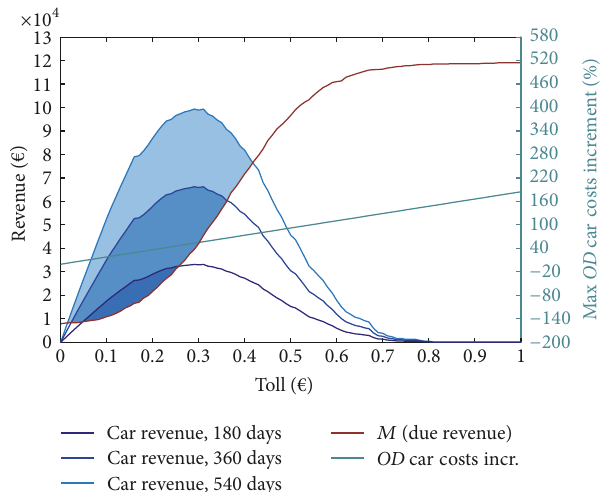
Figure 5: Number of days of operation of the pricing strategy in relation to the amount of the toll and associated OD car costs increment